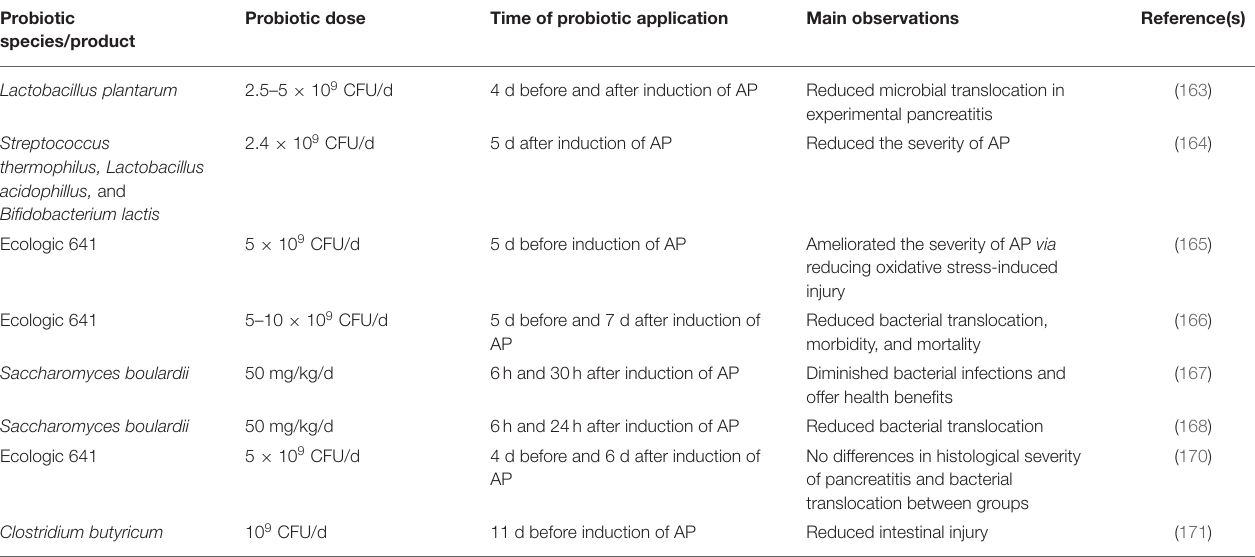
TABLE 1 | Summary of preclinical studies investigating the effects of probiotic application in acute pancreatitis